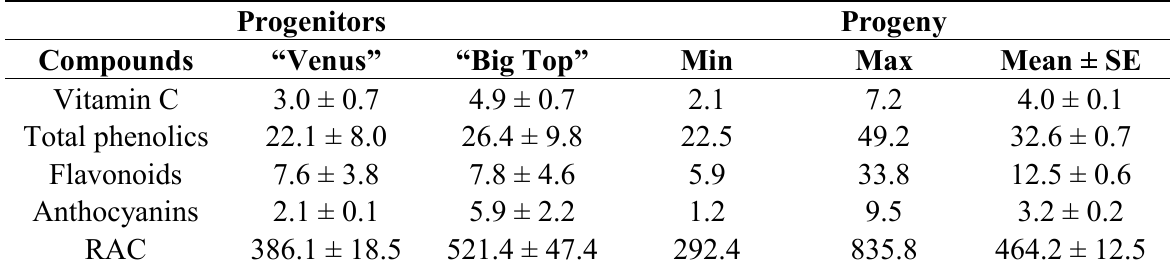
Table 2. Content of antioxidant compounds in the “Venus” × “Big Top” population. For progenitors data are means ± SE of two years (2009–2010). For the progeny ( n = 42–75 genotypes), data are means ± SE of four years of study